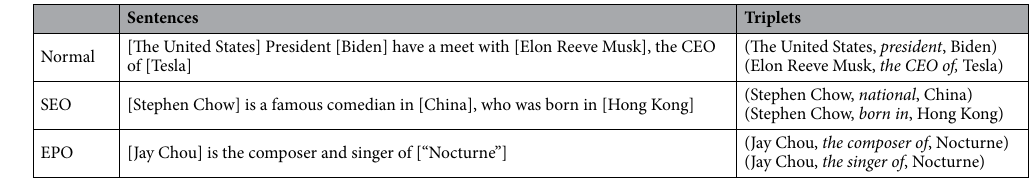
Sentences Table 1. Example of the Normal, SEO and EPO overlapping patterns.